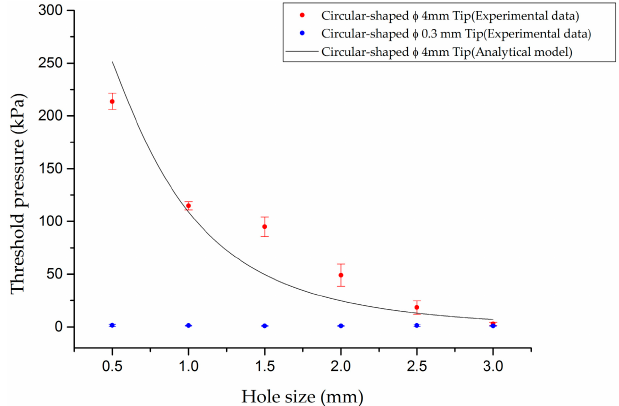
Figure 6. Relation between the threshold pressure and the hole size. The experimental results with the circular-shaped Ø 0.3 mm tip and Ø 4 mm tip are shown. The simple analytical model that is fitted with the circular-shaped Ø 4 mm tip test result is shown.